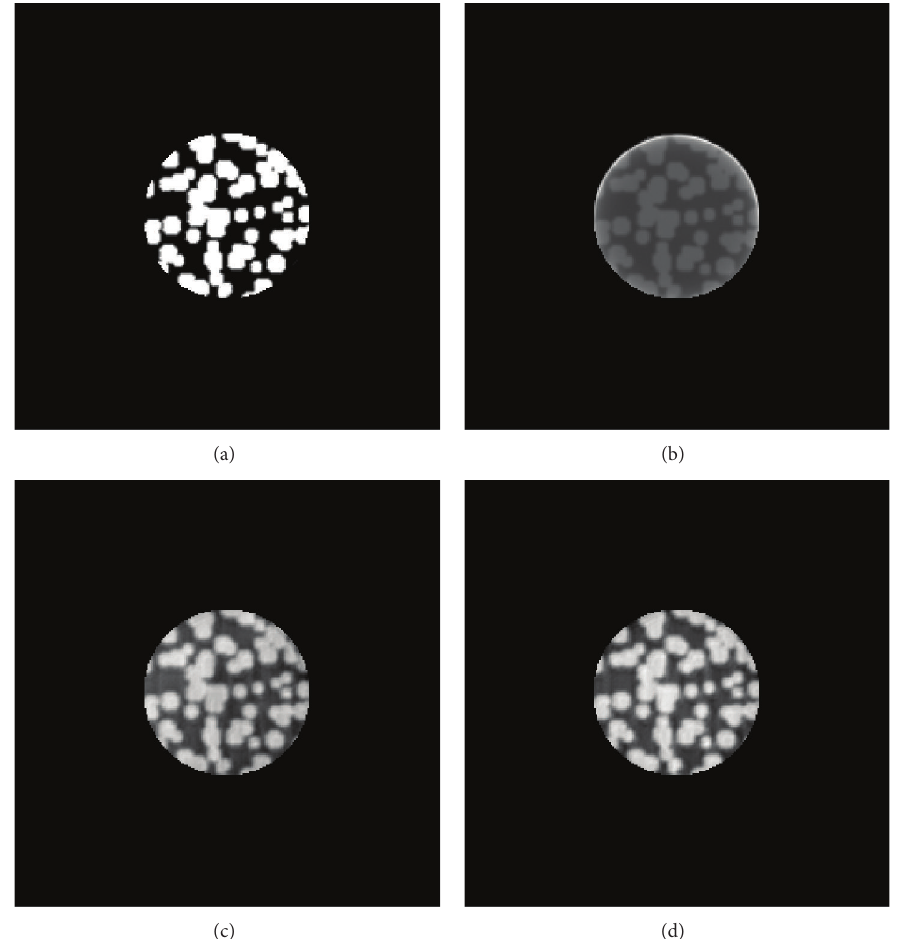
Figure 6: Reconstructed images of the local area in stacked particles phantom. (a) Local area in the phantom. (b) Local reconstruction using FBP. (c) Using wavelet method in [13]. (d) Using new wavelet method in this